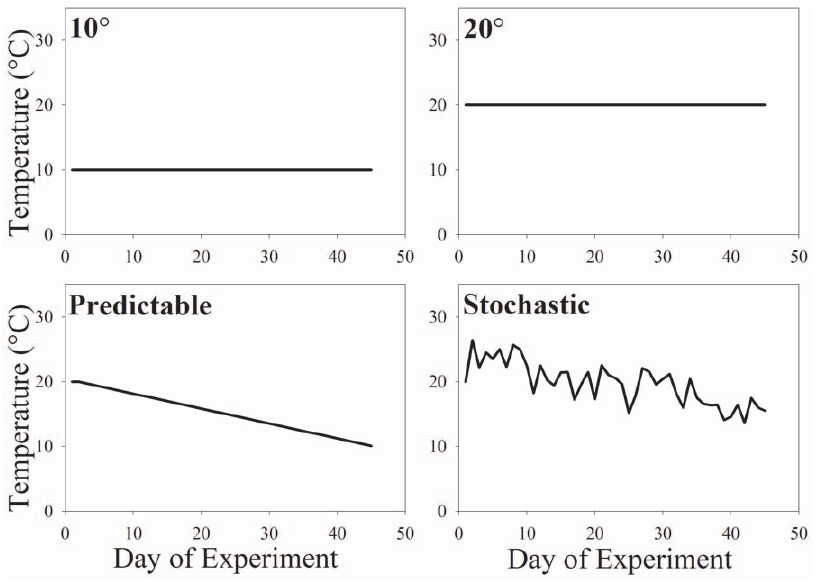
Figure 1. Four thermal treatments were used to study acclimatory responses by isopods: a stochastic decline in temperature that mimicked air temperatures in autumn; a predictable decline in temperature from 20 6 C to 10 6 C; a constant temperature of 20 6 C; and a constant temperature of 10 6 C.